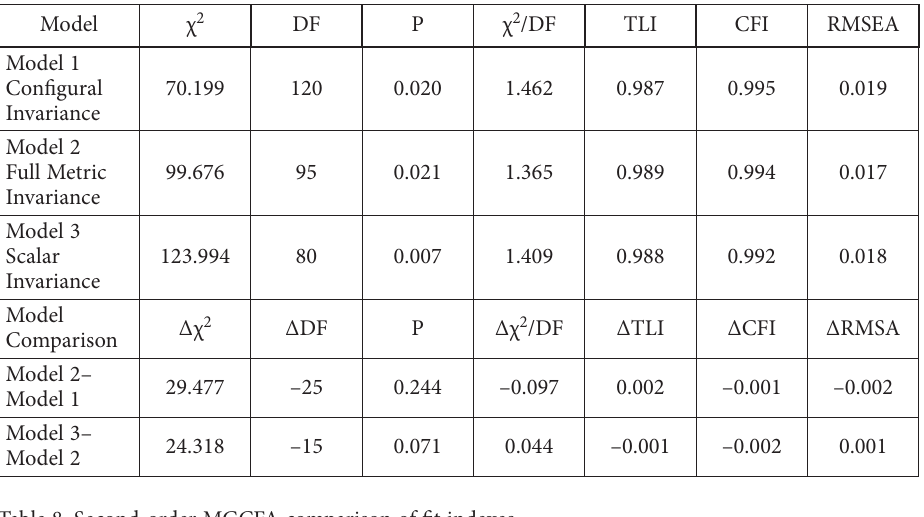
Table 8. Second-order MGCFA comparison of fit indexes Model Comparison